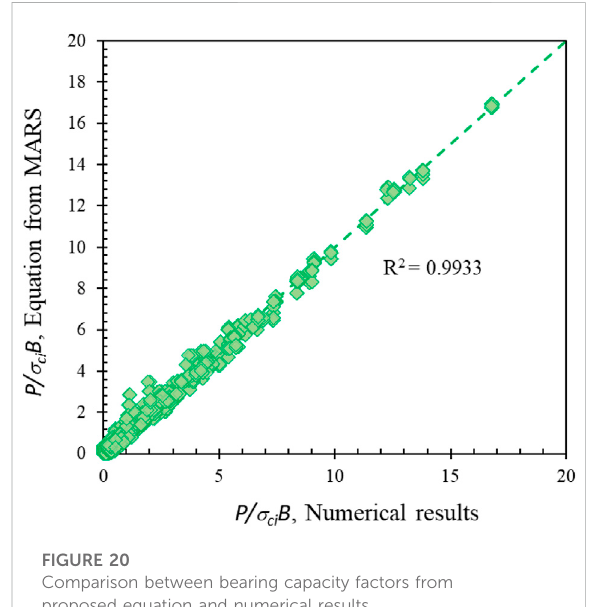
FIGURE 20 Comparison between bearing capacity factors from proposed equation and numerical